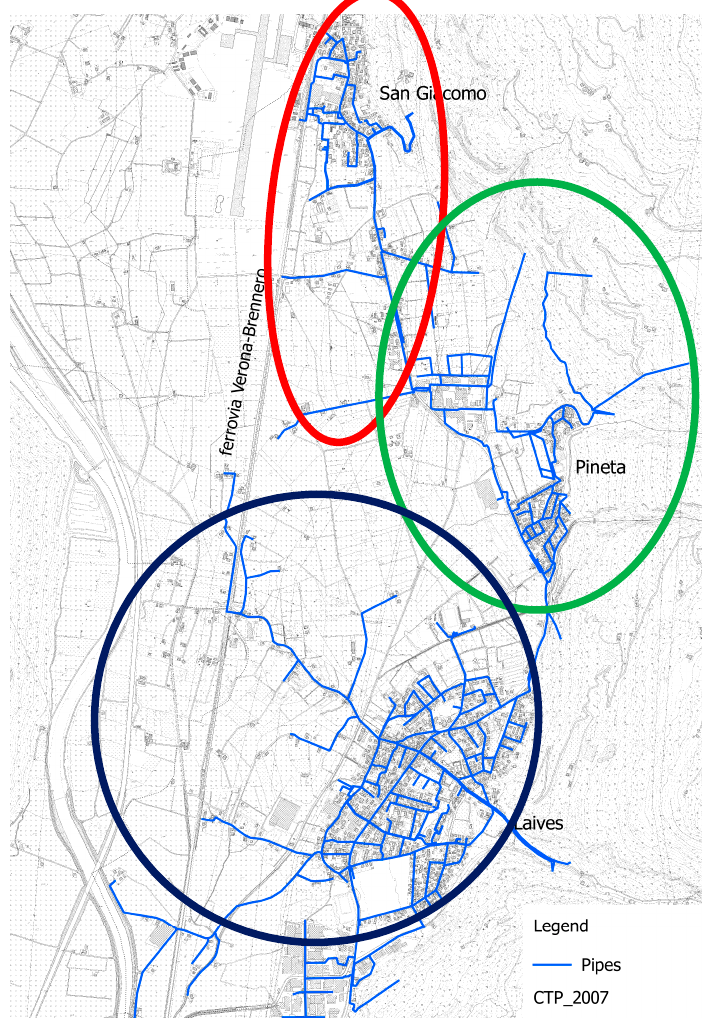
Figure 6. Geographical representation of Laives water distribution network and the three interconnected districts of San Giacomo, Pineta and Laives.